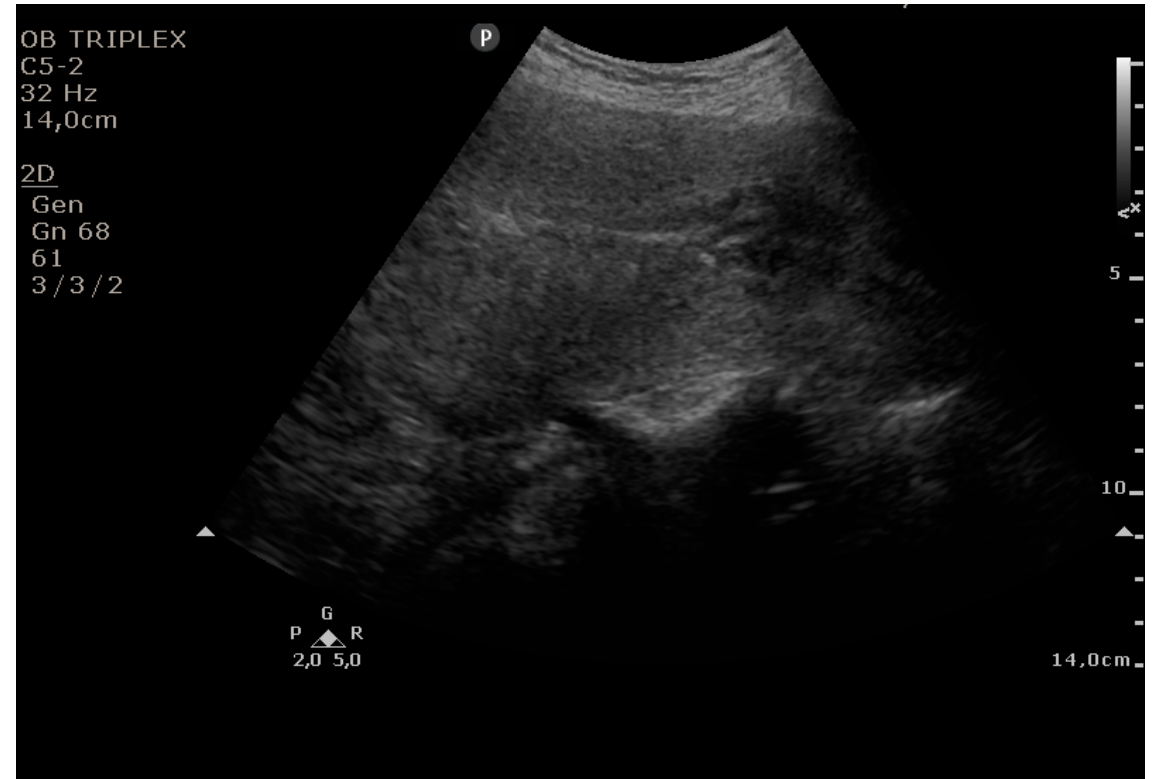
Figure 3. Grade 2: less than one-half of the endometrial length occupied by blood or debris.